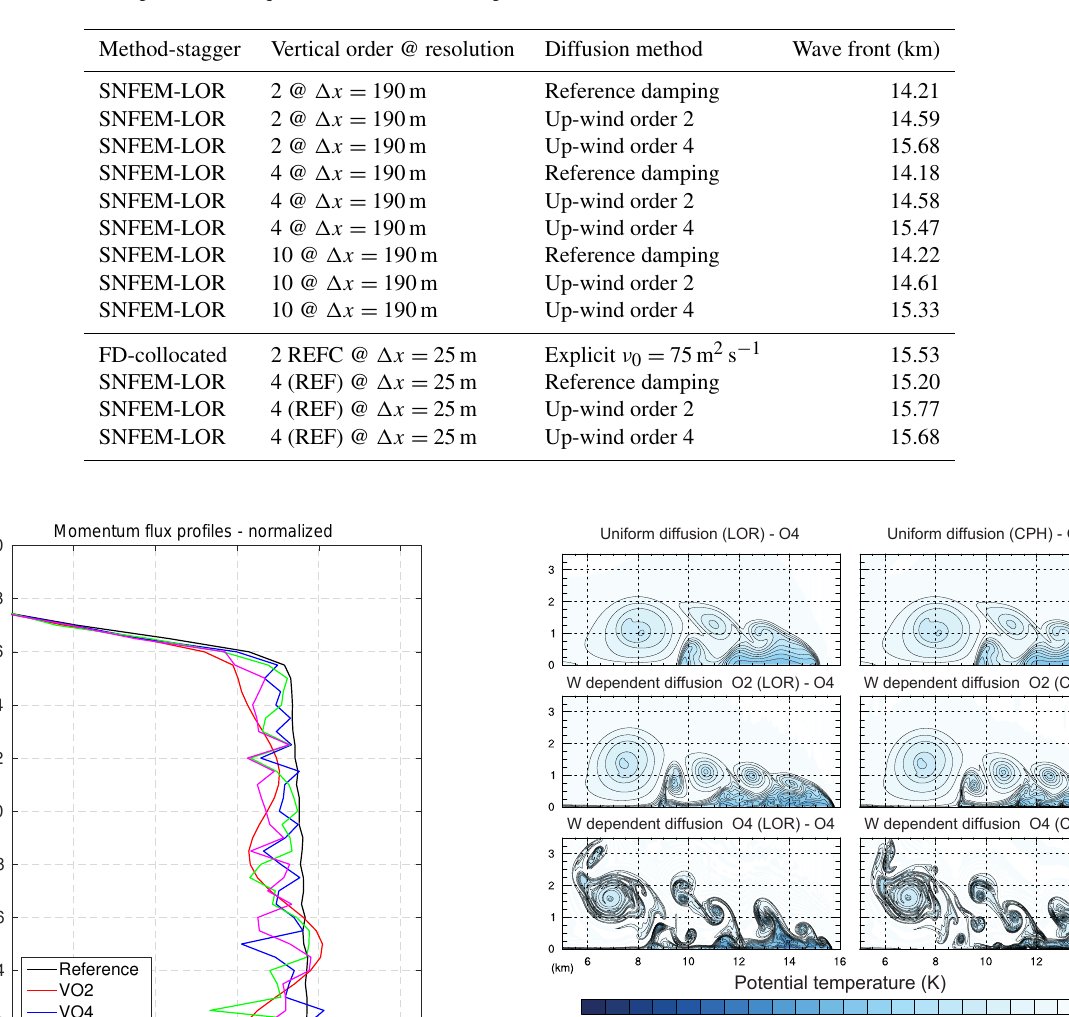
Table 2. Cold wave front position ( θ (cid:48) = − 1 . 0K) for all orders of accuracy and diffusion methods. Reference damping is uniform second-order diffusion on all prognostic variables such that ν = 75m 2 s − 1 combined with horizontal hyperdiffusion on scalars and vertical fourth-order up-wind diffusion. The reference solution wave front position (finite difference (FD) method at 25m resolution) by Straka et al. (1993) is shown in bold (REFC) compared to the equivalent result from Tempest.